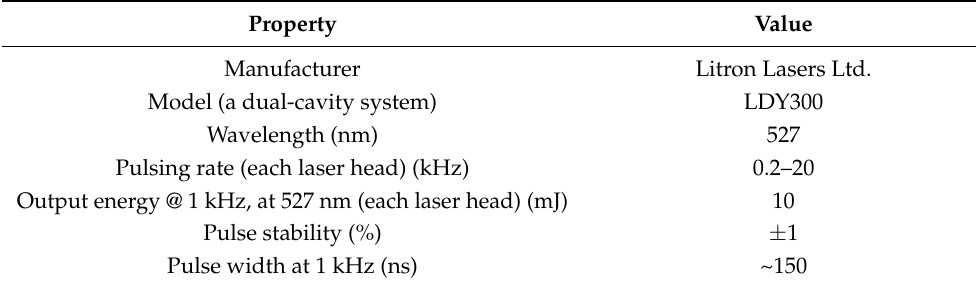
Table 2. Specifications of dual-head diode-pumped Nd: YLF